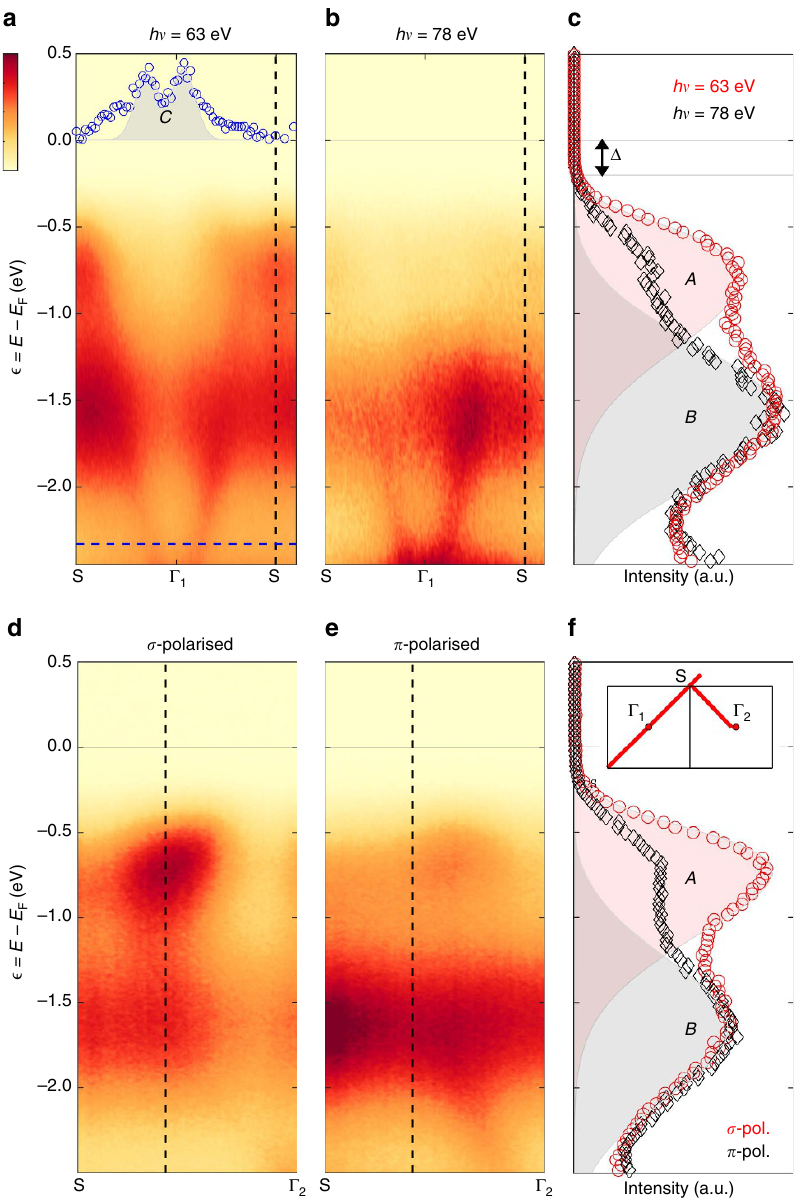
Figure 2 | Ruthenium band structure. ( a , b ) Photoemission spectra recorded along the high-symmetry direction G 1 (cid:2) S for incident circularly polarized light with photon energies h n as indicated. Dark colours correspond to high intensities. Blue points in a show the momentum distribution curve at the binding energy indicated by the horizontal dashed line. The double peak structure is attributed to the C band. ( c ) Energy distribution curves (EDCs) at the S point, normalized at binding energy E ¼ E (cid:2) E F ¼ (cid:2) 1.8eV. ( d , e ) Linear light polarization dependence along the S (cid:2) G 2 direction at h n ¼ 65eV. ( f ) EDCs at the momentum indicated by the vertical dashed lines. In both ( c , f ), the A and B bands are indicated by red and grey shading,